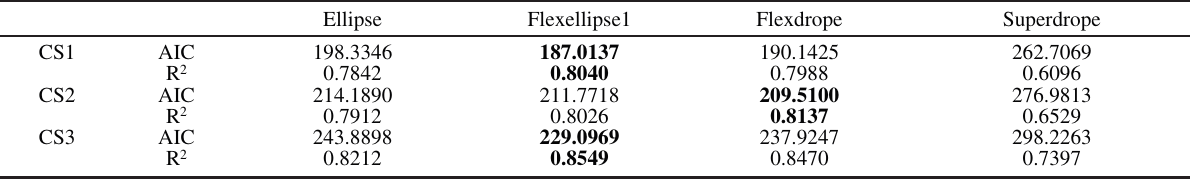
Table 3. – Mean R 2 and AIC values for different shape descriptions of hake. The highest R 2 and lowest AIC values for each cross-section are in bold and represents the penetration model for the single cross-sections.